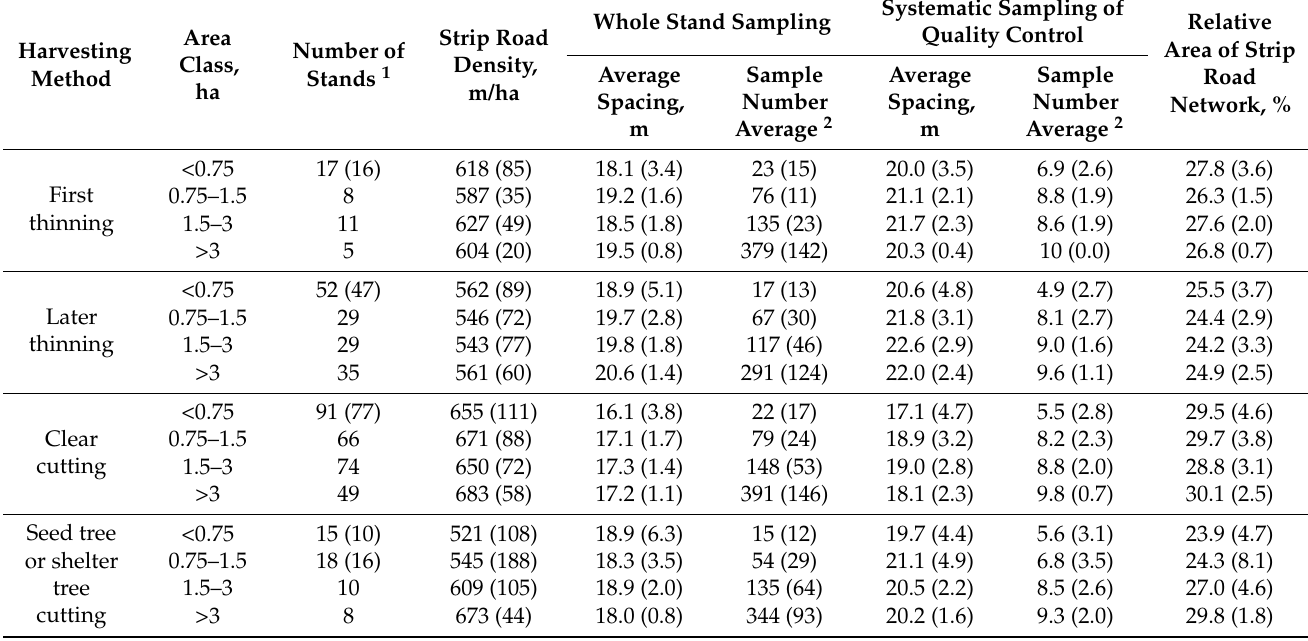
Table 3. Average strip road variables by stand area class and harvesting method. The standard deviations are provided in parentheses, and in this table, they describe the variation of the stand-wise values of the variable within each area class.